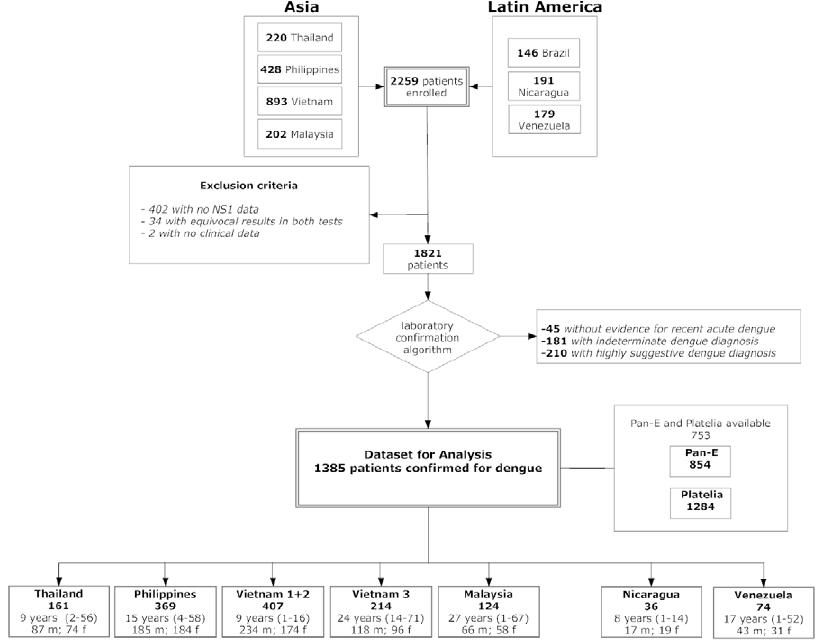
Figure 1. Flow chart summarising multi-country enrolment of dengue patients and basis for the final dataset.